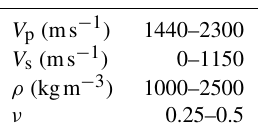
Table 4. Seismic velocity ( V p , V s ), density ( ρ ), and Poisson’s ratio ( ν ) bounds used for Zoeppritz